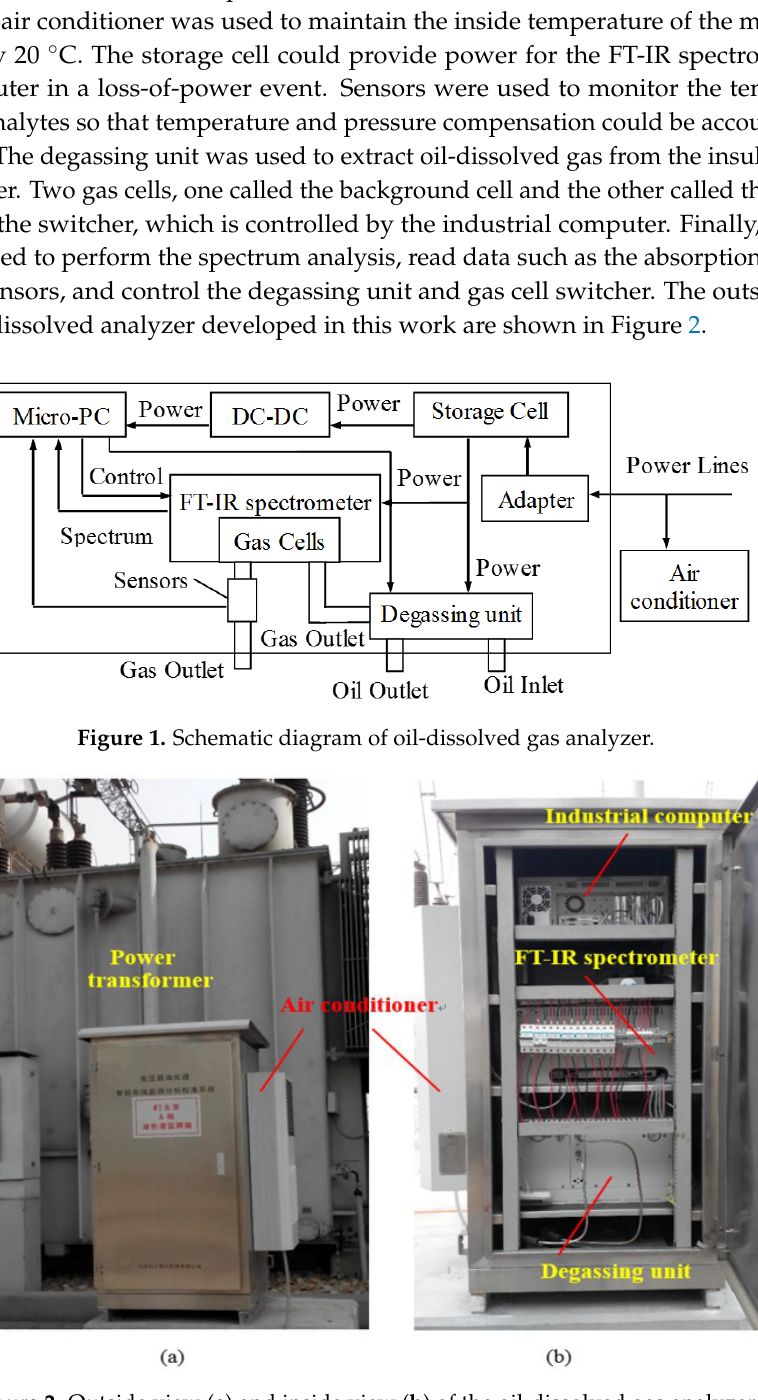
Figure 2. Outside view ( a ) and inside view ( b ) of the oil-dissolved gas analyzer.